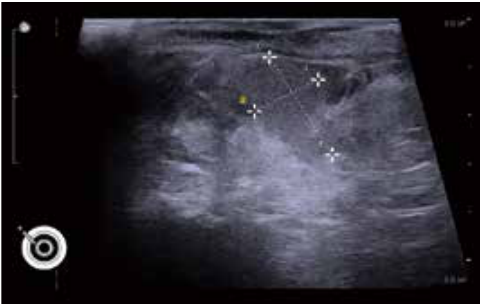
Figure 2 TRUS image of sagittal view at 10 o’clock position. Ultrasound scan demonstrated that the abscess extended and crossed the external sphincter from the intersphincteric groove into the ischiorectal fossa.